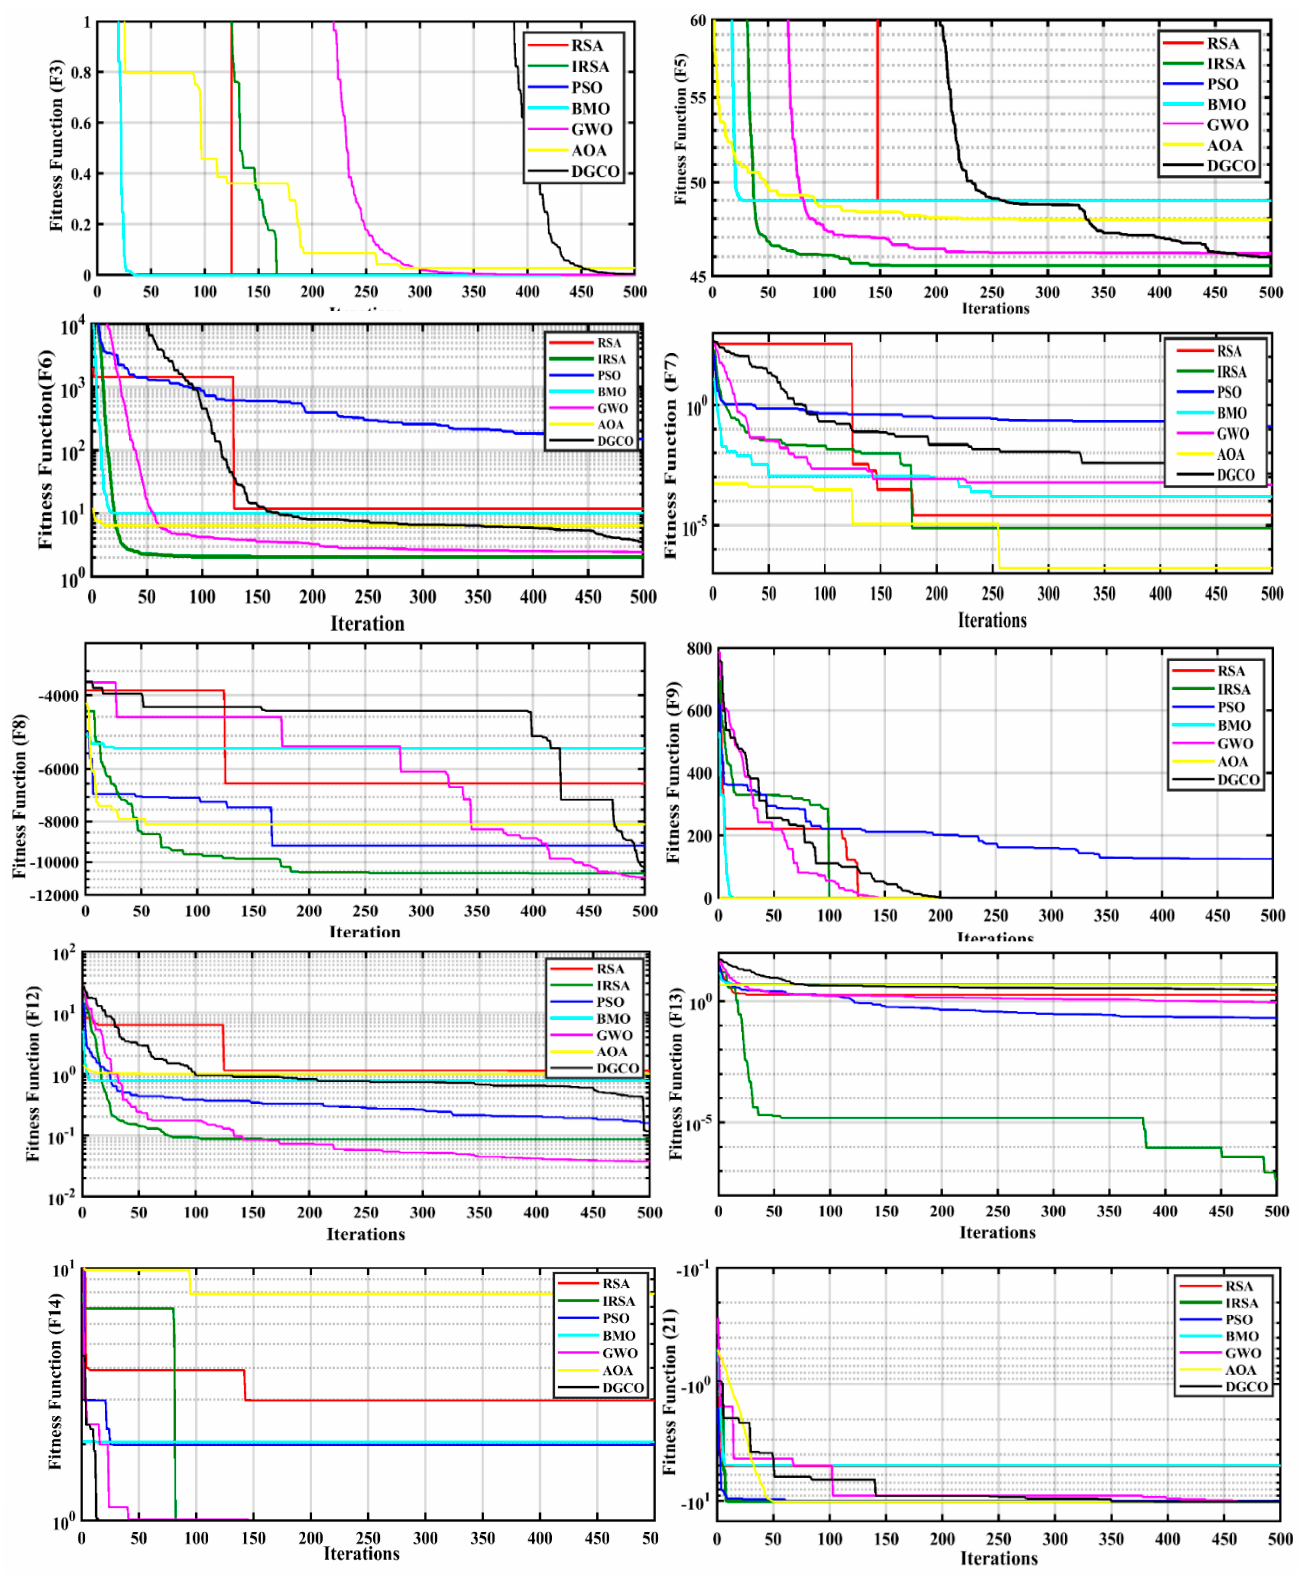
Figure 4. Convergence curves for F1–F23.